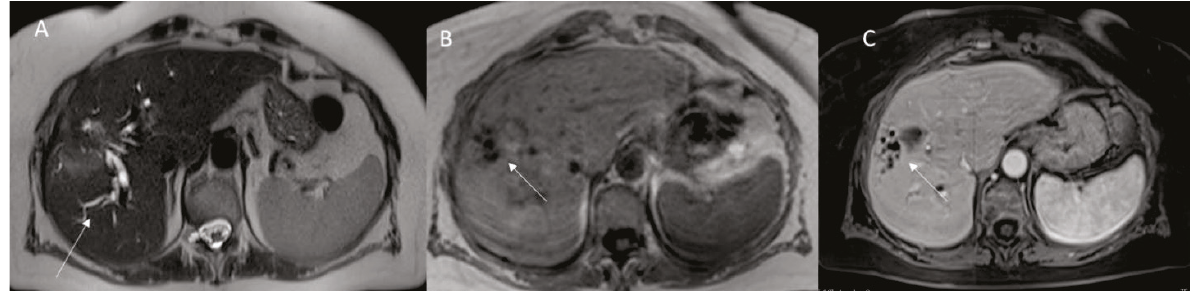
Figure 2. Woman 63 year at 1-month follow-up after RFA of liver metastasis. MRI assessment (( A ): HASTE T2-W sequence; ( B ): in phase T1-W sequence and ( C ): porta phase of contrast study), ablated zone with biliary tree damage (arrow).